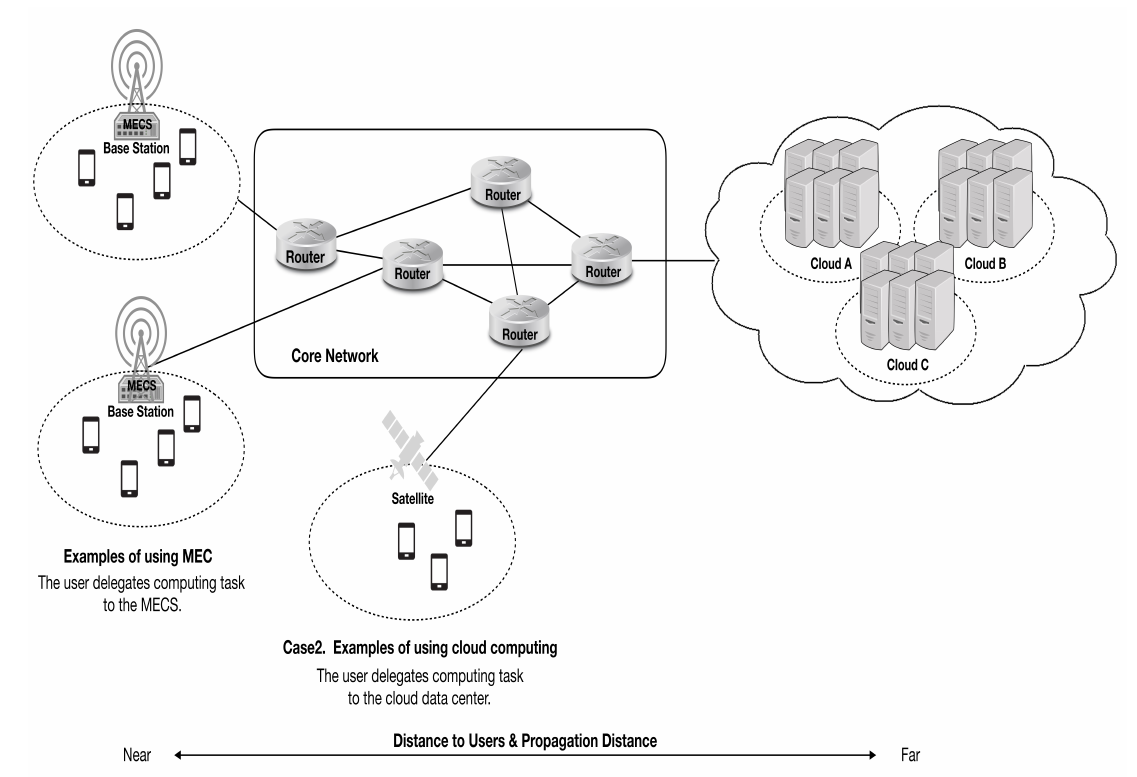
Figure 1. The existing cloud computing architecture and Multi-Access Edge Computing (MEC)